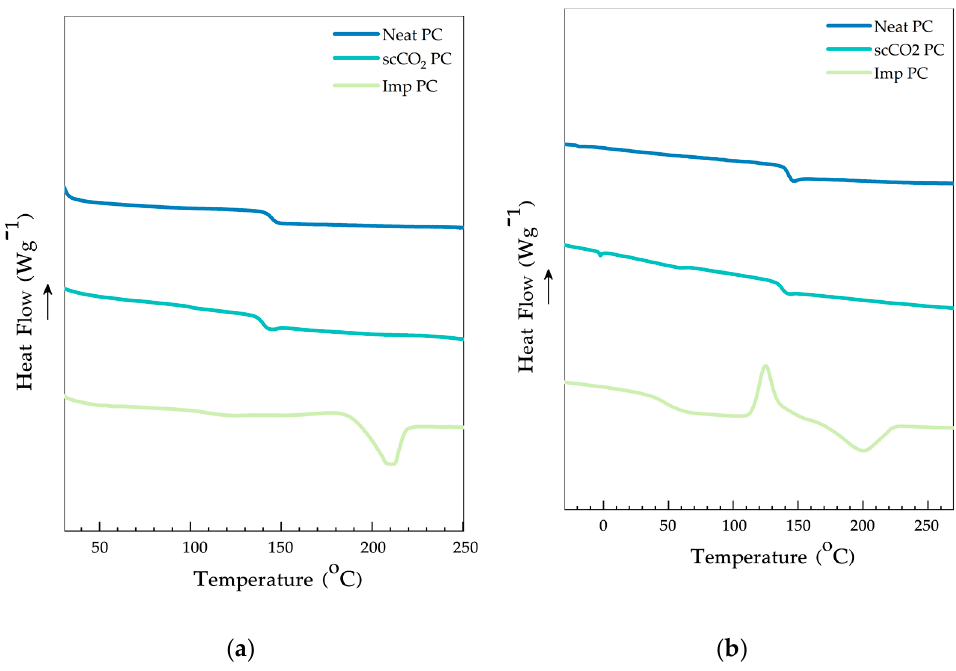
Figure 10. DSC thermograms of ( a ) the first heating and ( b ) second heating of neat PC, PC after scCO 2 treatment, and PC impregnated with clove extract (CL = 18.5%) at 60 °C and 10 MPa.